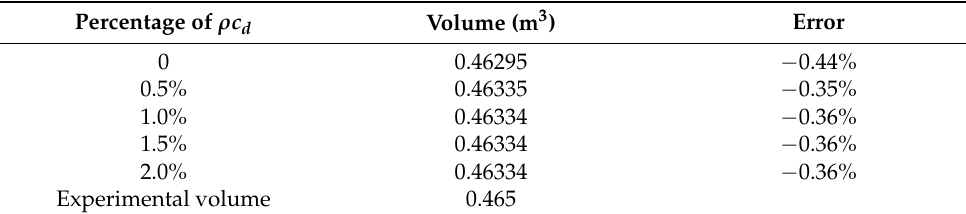
Table 3. Volume results for five different percentages of ρ c d for viscous pressure coefficient and errors with respect to the experimental volume of 0.465 m 3 .